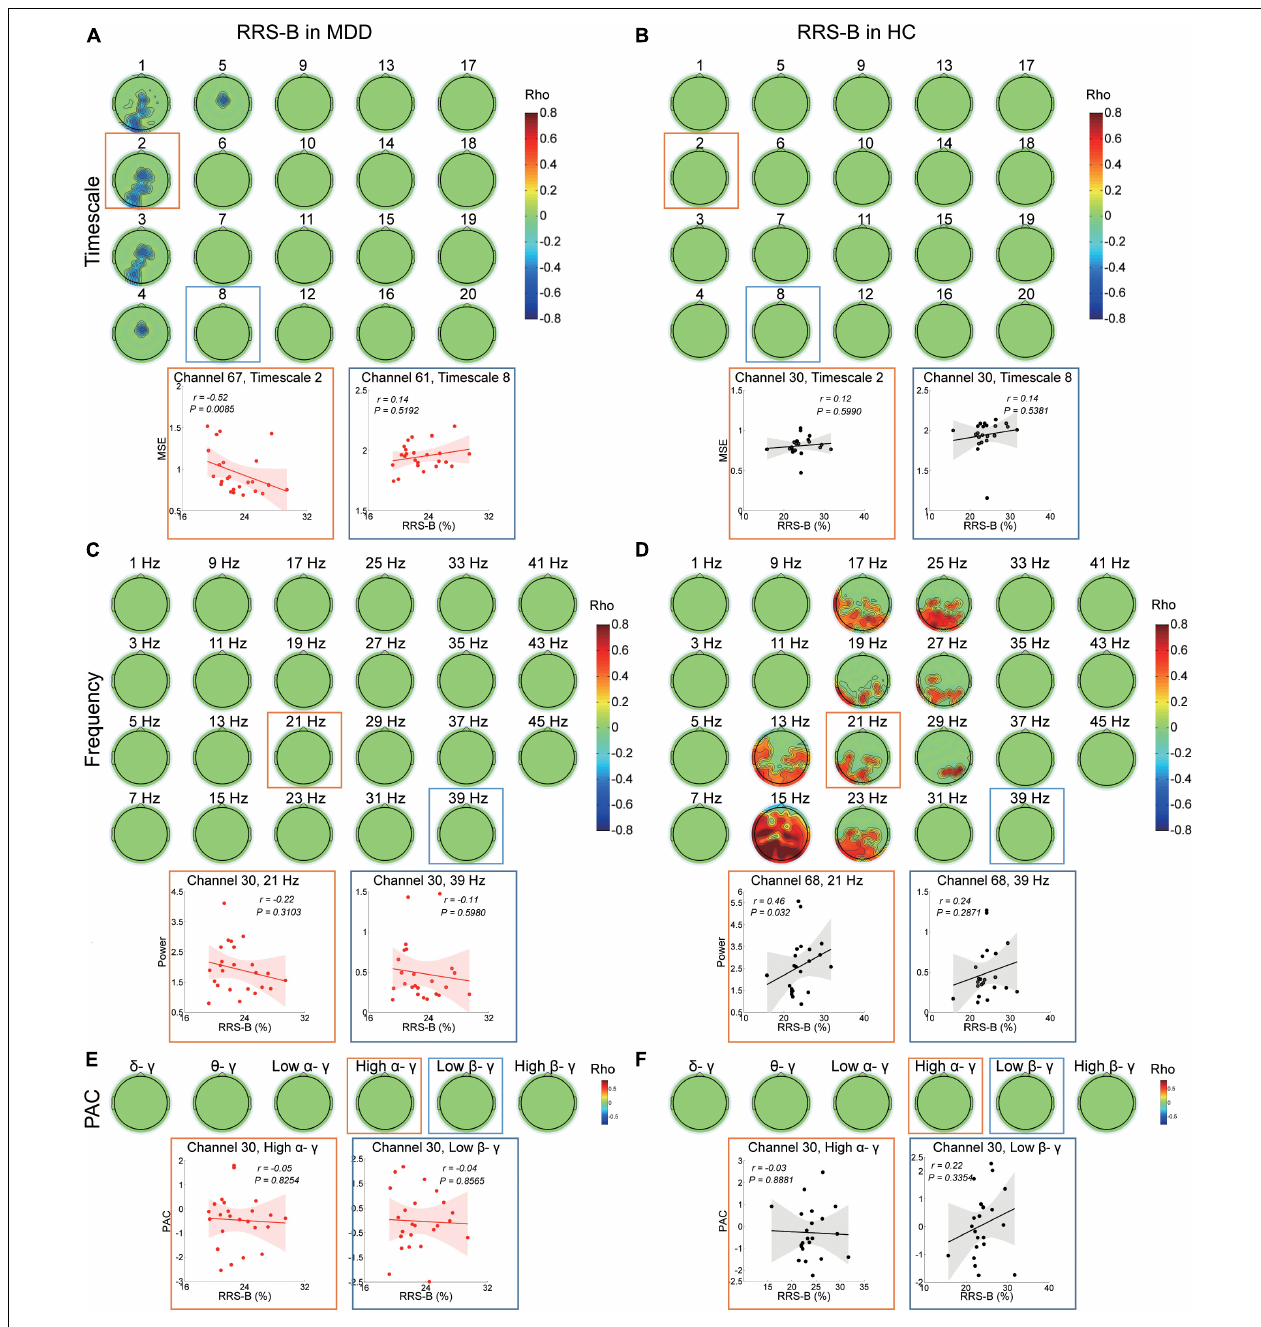
FIGURE 4 | Association between EEG dynamics and brooding rumination in the MDD and HC groups. (A) Top: Topographies illustrate the significant correlation (negative clusters P = 0.048) between RRS-B scores and MSE in the MDD group. Bottom: Scatter plots show examples in the occipital region at the fine (channel 67, timescale 2, r = − 0.52, P = 0.009) and in the parietal region at coarser timescales (channel 61, timescale 8, r = 0.14, P = 0.519). (B) Topographies illustrate no significant (clusters P > 0.05) correlation between RRS-B scores and MSE in the HC group. Bottom: Scatter plots show examples in the central region at the fine (channel 30, timescale 2, r = 0.12, P = 0.599) and coarser timescales (channel 30, timescale 8, r = 0.14, P = 0.538). (C) Topographies illustrate no significant (cluster P > 0.05) correlation between RRS-B scores and power (presented with a step of 2 Hz) in the MDD group. Bottom: Scatter plots show examples in the central region in the beta (channel 30, 21 Hz, r = − 0.22, P = 0.31) and gamma bands (channel 30, 39 Hz, r = − 0.11, P = 0.598). (D) Top: Topographies illustrate the significant correlation (positive cluster P = 0.015) between RRS-B scores and power (presented with a step of 2 Hz) in the HC group. Bottom: Scatter plots show examples in the parietal midline region in the beta (channel 68, 21 Hz, r = 0.46, P = 0.032) and gamma bands (channel 68, 39 Hz, r = 0.24, P = 0.287). (E,F) Top: Topographies illustrate no significant (cluster P > 0.05) correlation between RRS-B scores and PAC in the MDD and HC groups. Scatter plots show examples of high alpha/gamma (channel 30, r = − 0.05, P = 0.825 in the MDD group; r = − 0.03, P = 0.888 in the HC group) and low beta/gamma (channel 30, r = − 0.04, P = 0.857 in the MDD group; r = 0.22, P = 0.335 in the HC group) PAC in the central